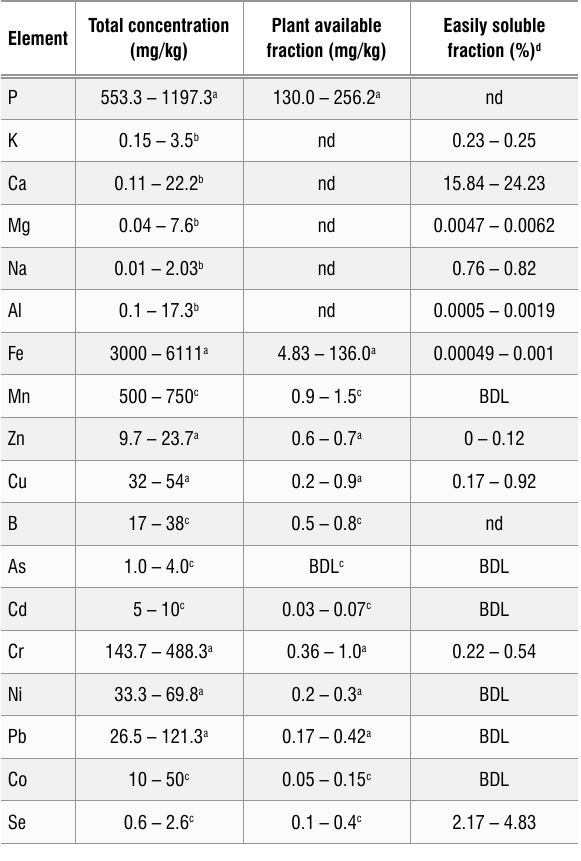
Table 2: Typical elemental concentrations of total plant available fraction (mg/kg) and easily available fraction (%) of selected fly ash